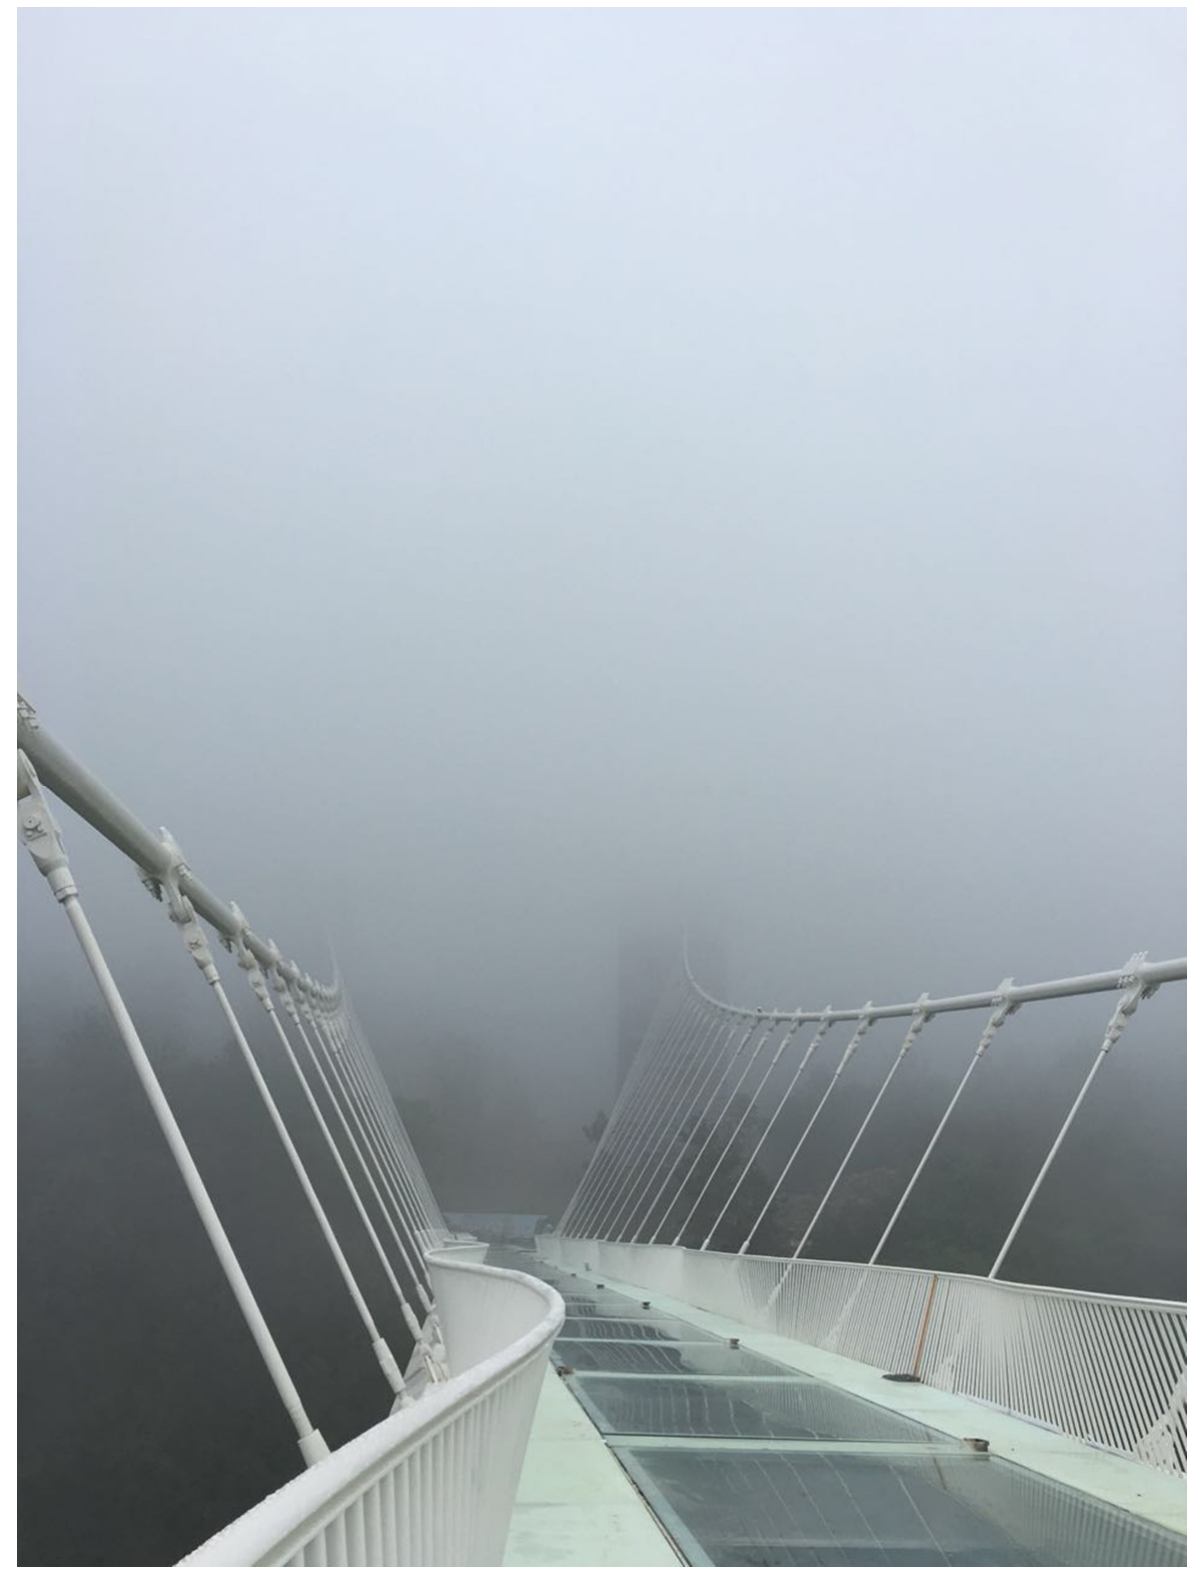
Fig. 6 Zhangjiajie